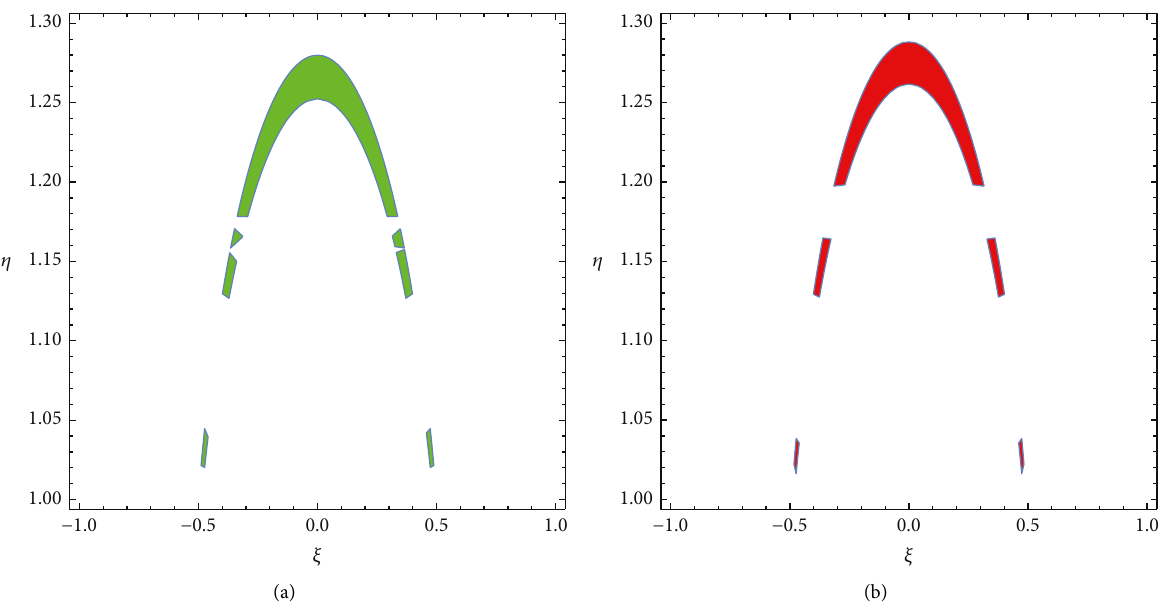
Figure 11: Condition (i): projection of stability regions (a) b � 0 . 58 and a � 0 . 68; (b) b � 0 . 60, and a � 0 . 68.